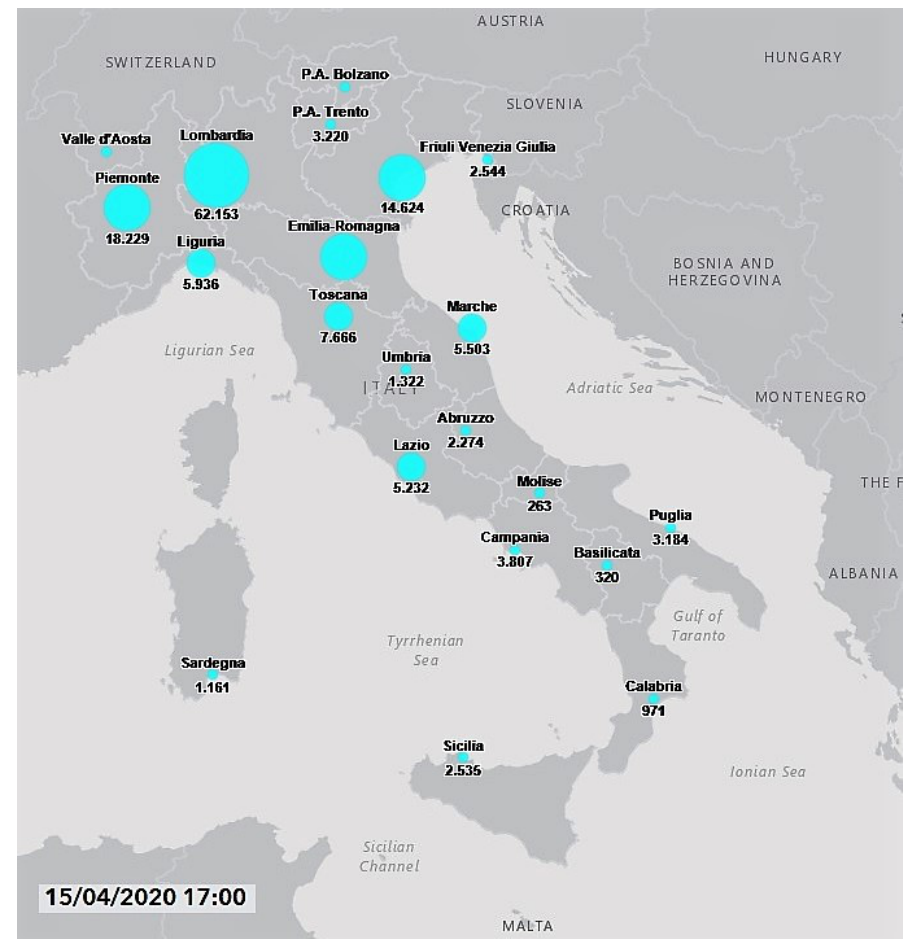
Figure 3. Geographical distribution of COVID-19 pandemic in